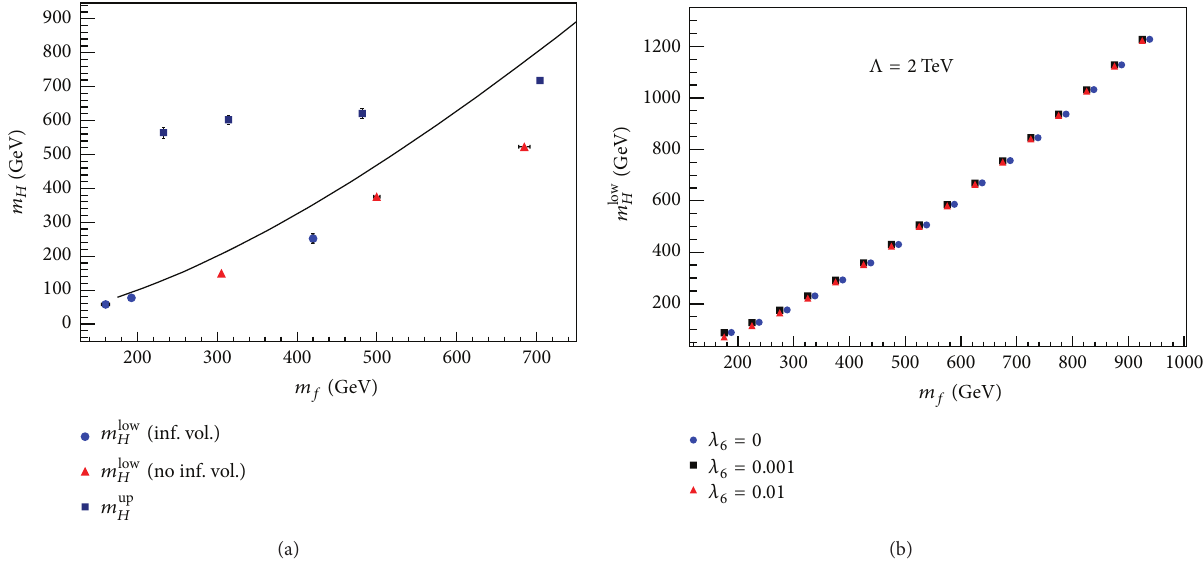
Figure 5: (a) The dependence on the fermion mass of the upper and lower Higgs boson mass bounds, at the cutoff scale Λ = 1.5 TeV. Data points from lattice calculations are shown. Results for the lower bound without infinite-volume extrapolation, using only 24 3 ×48 lattices, are also shown for comparison. The solid line results from a one-loop calculation of the effective potential, as explained in the text. (b) Effects of a 𝜙 6 operator with coupling 𝜆 6 for the lower bound of the Higgs boson mass, at various fermion masses and the cutoff scale Λ = 2 TeV. Three values of the coupling constant 𝜆 6 are